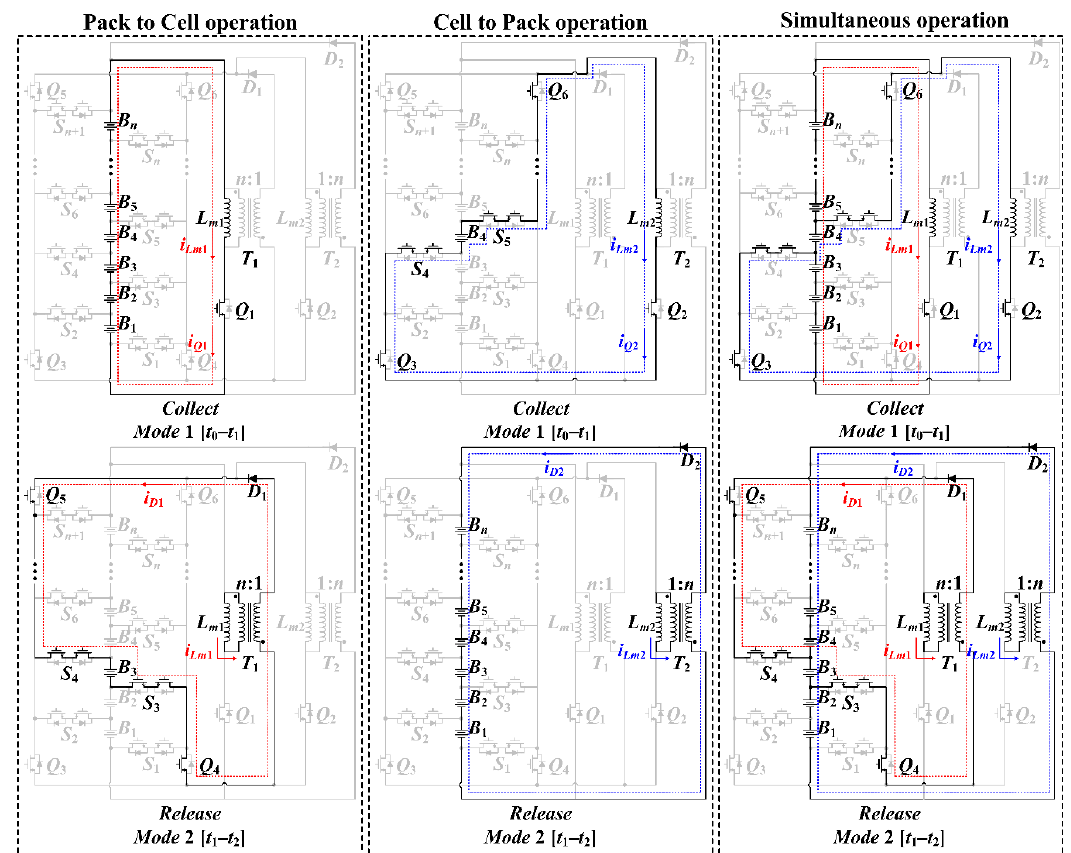
Figure 3. Operation modes for pack-to-odd cell and even cell-to-pack operations.